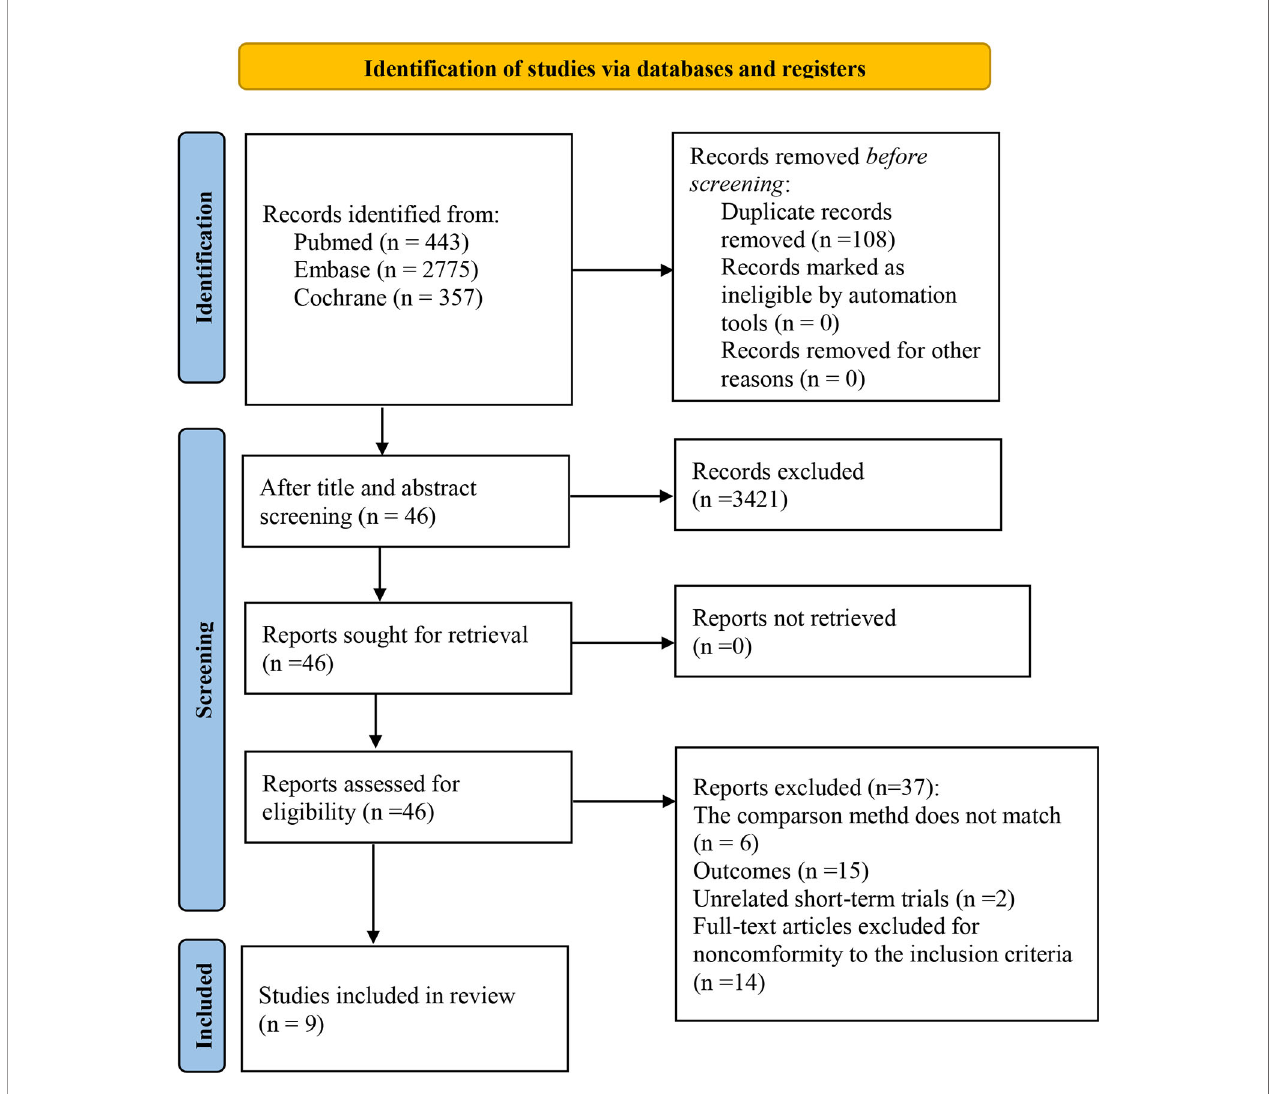
FIGURE 1 | PRISMA fl ow chart of the study selection